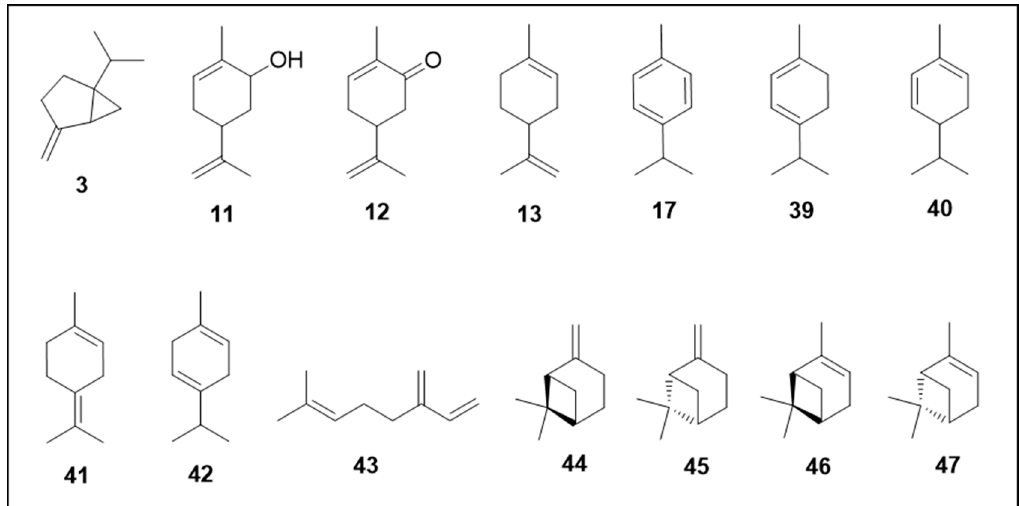
Figure 7. Monoterpenes active against Ae. aegypti .